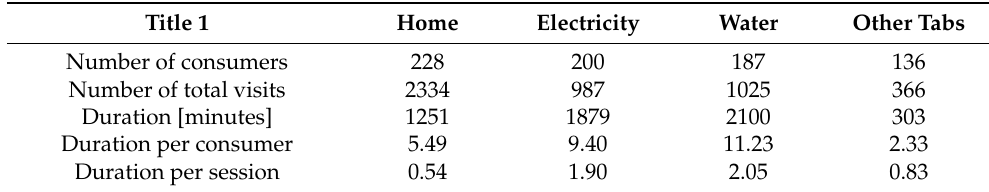
Table 1. Number of portal visits and visit duration by tabs.